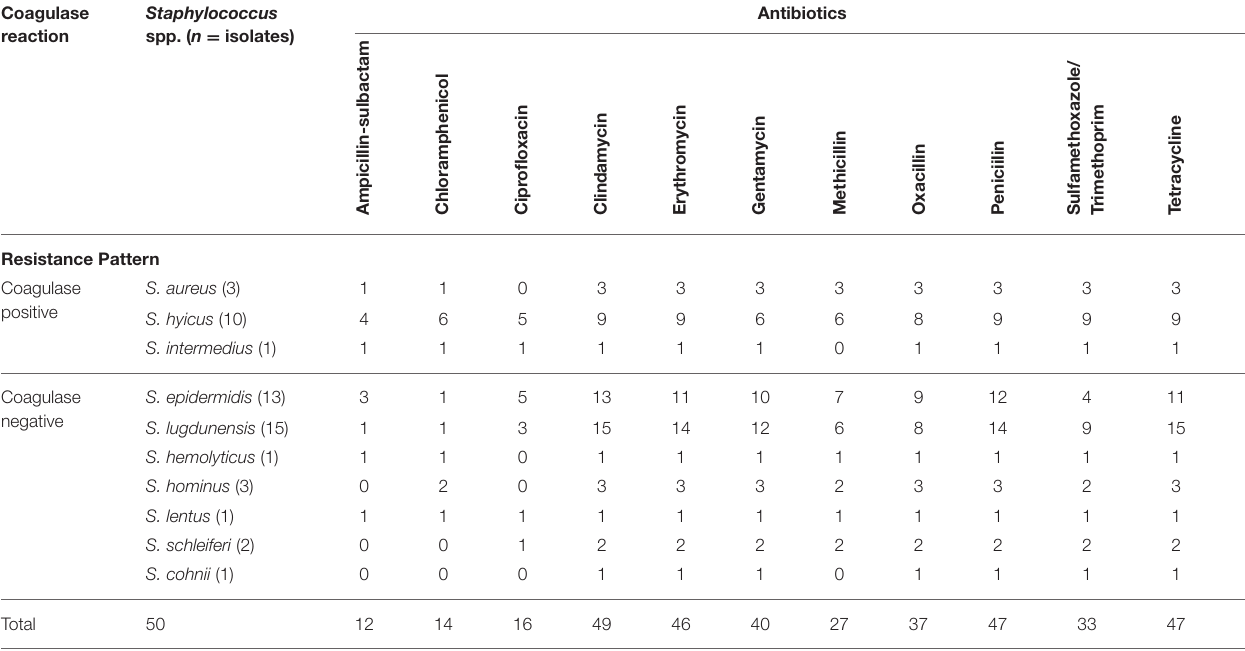
TABLE 2 | Distribution of Staphylococcus spp. isolated from chicken meat samples according to their species diversity and multidrug resistance pattern. Staphylococcus Coagulase reaction spp. ( n = isolates)